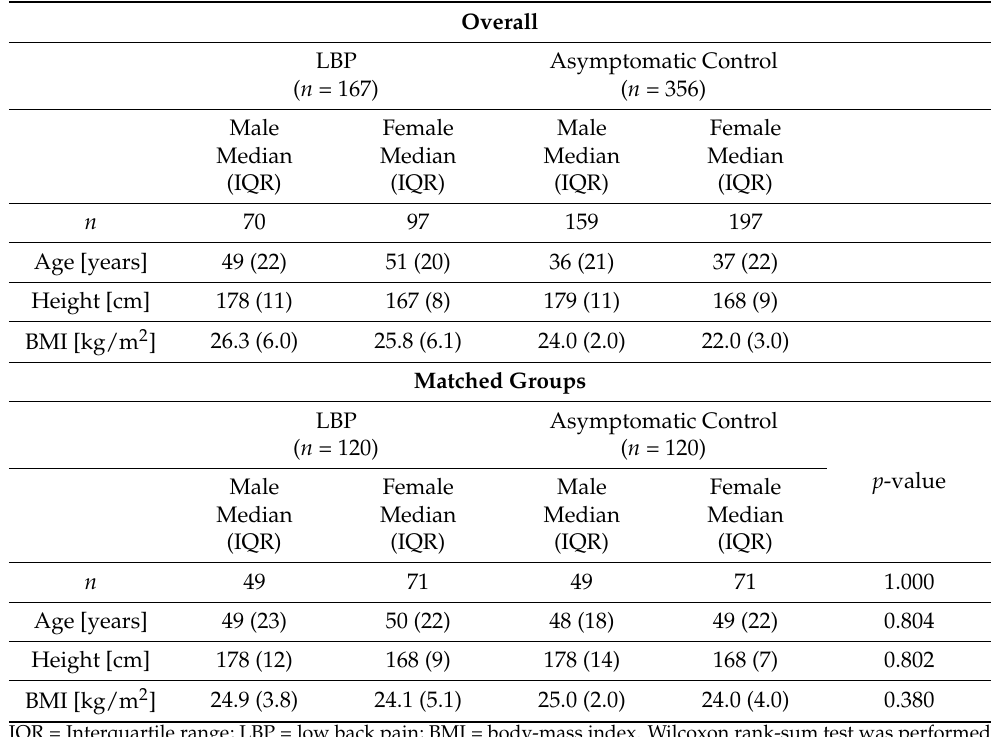
Table 1. Demographics and anthropometrics of included participants in both the LBP and the control